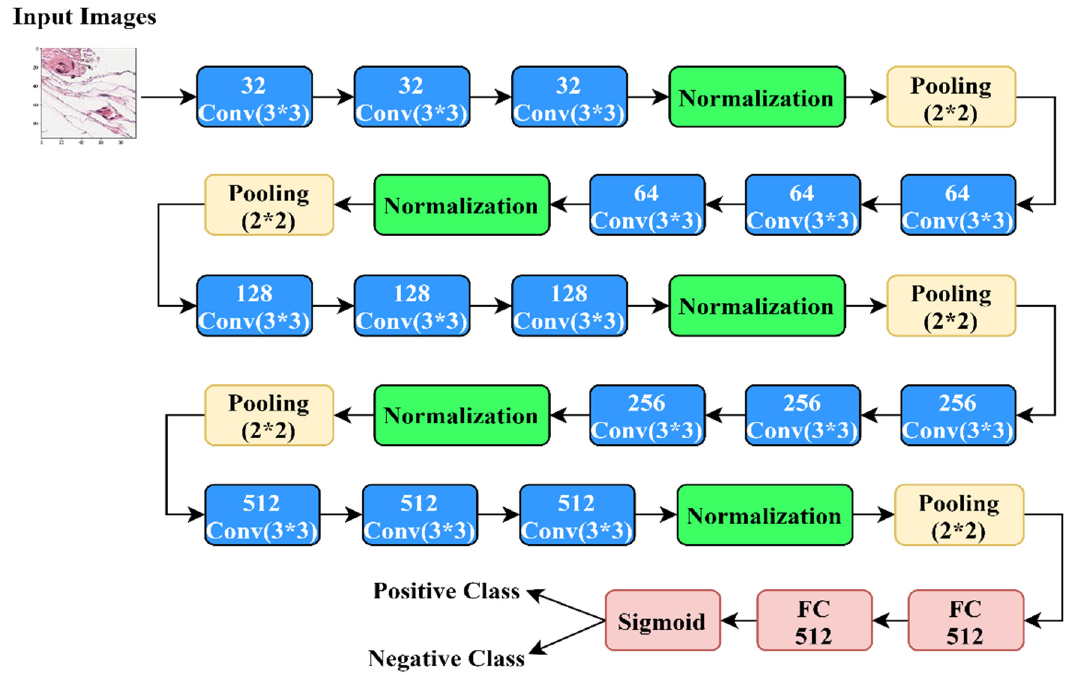
Figure 1. A schematic diagram of the proposed network architecture.